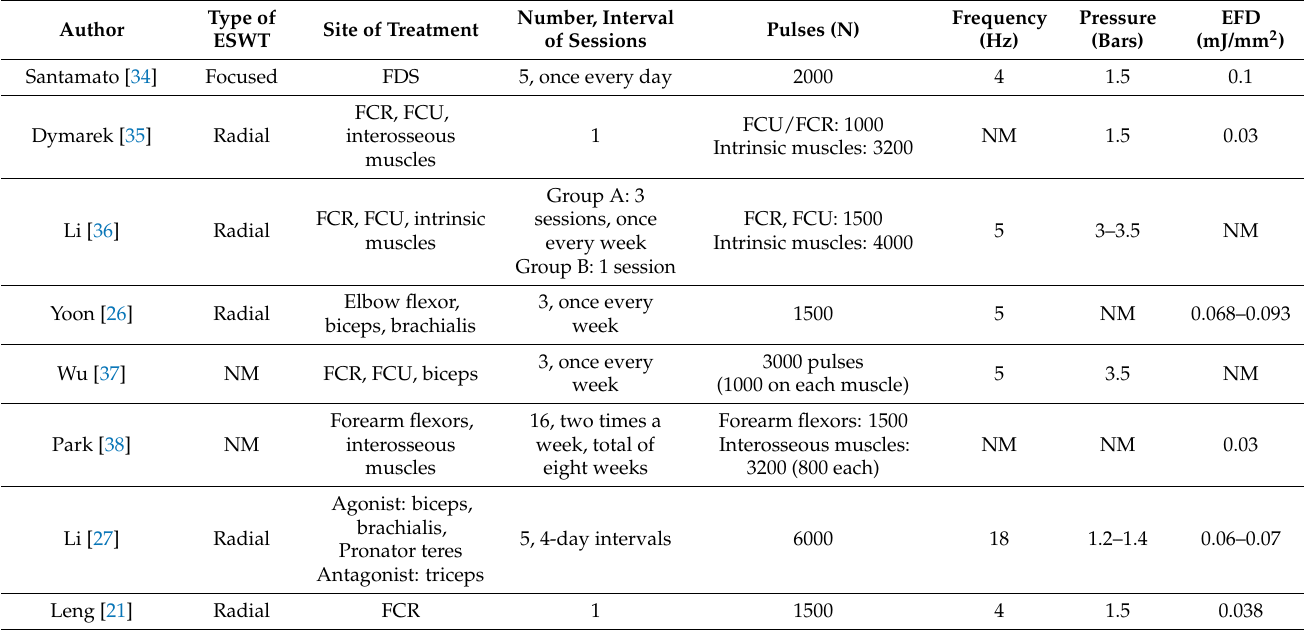
Table 2. Upper limb studies: ESWT